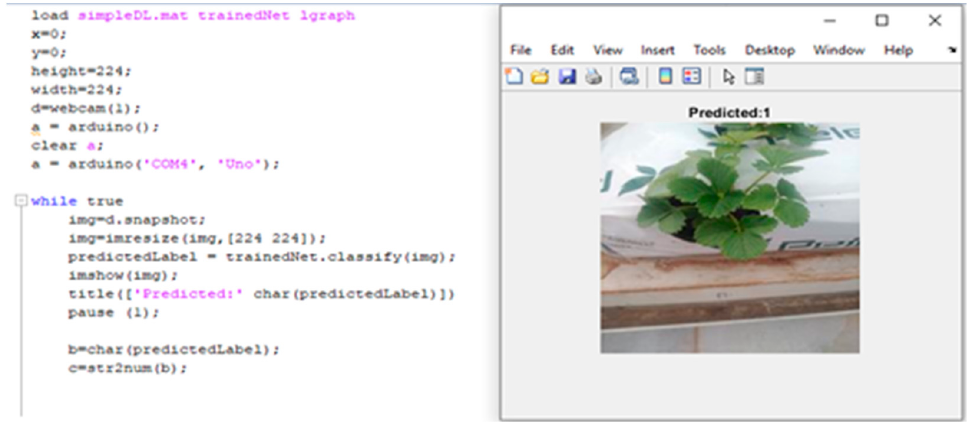
Figure 17. Test program and program